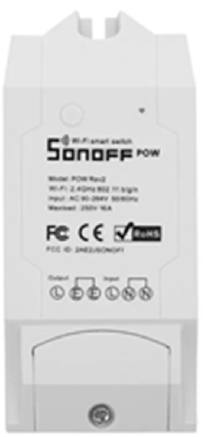
Figure 9. Sonoff Pow R2.